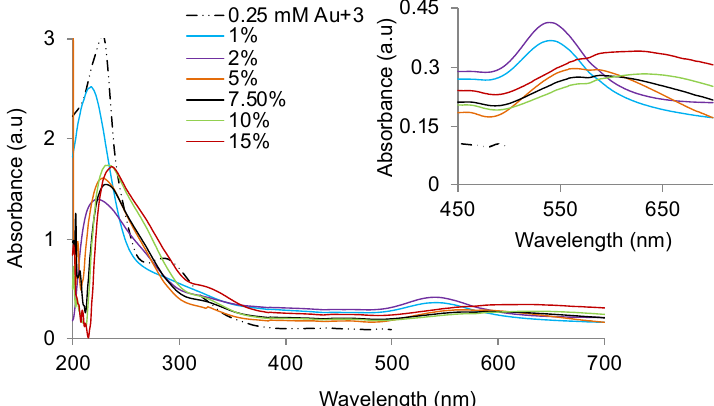
Figure 5. UV–Vis absorbance spectra and (insert) absorbance in PR region in the mixtures of 0.25 mM HAuCl 4 and F127 as a function of the copolymer concentration 2 h after incubation at 4 °C. Copolymer concentration varied from 1–15% w / w .